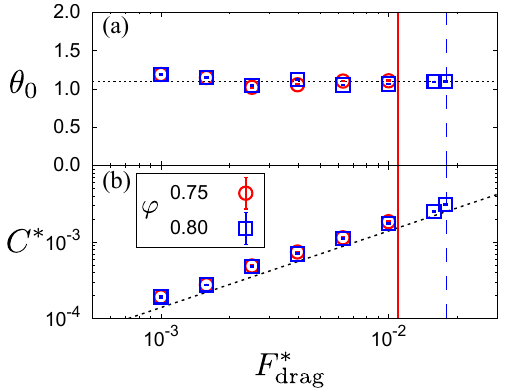
Figure 4. Drag force dependencies of (a) θ 0 and (b) C for ϕ = 0 . 75 and 0 . 80 when we fix D = 10 d , where we have introduced C ∗ ≡ C / k n . The dotted lines in panel (a) and (b) are θ 0 = 1 . 1 and Eq. (7), respectively. Here, the solid and dashed vertical lines represent the yield forces F Y (cid:39) 1 . 1 × 10 − 2 k n d and 1 . 8 × 10 − 2 k n d for ϕ = 0 . 75 and 0 . 80, respectively (see also Fig. 2).